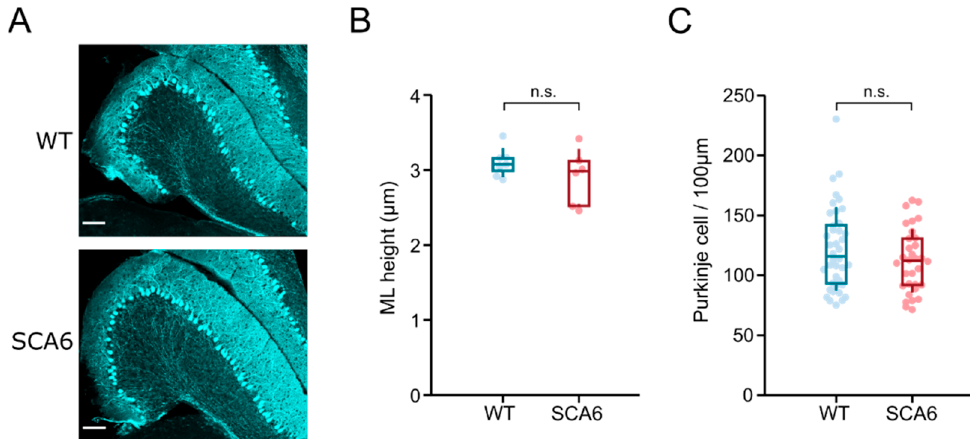
Figure 5. Flocculus morphology appears normal in SCA6 84Q mice. ( A ) Anti-calbindin immunohisto- chemistry in the flocculus of wild-type (WT) and SCA6 animals at 7.5 months. Anti-calbindin antibody stained Purkinje cells and showed normal flocculus morphology in SCA6 84Q mice. ( B ) Measurement of molecular layer height showed no change in SCA6 84Q flocculus, and Purkinje cell density was also unchanged ( C ). Comparisons were made with a non-parametric Mann–Whitney U-test.